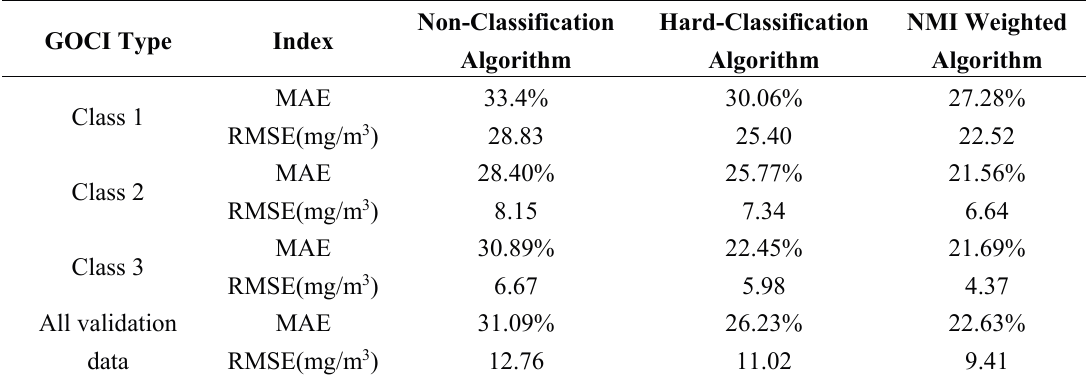
Table 3. Comparison of the Chl-a estimation by different